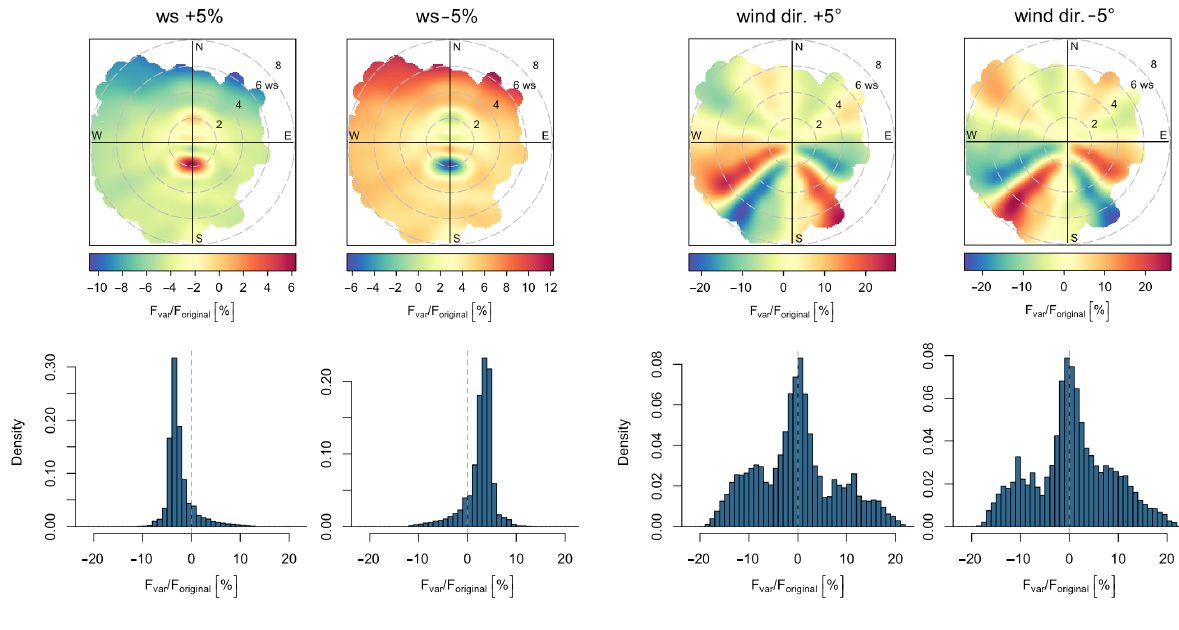
Figure 8. Variation experiment with the Operational Street Pollution Model (OSPM). For the variation of the input parameters wind speed by 5% and the wind direction by ± 5 ◦ , the output of the dilution factor F var in relation to the to the original dilution factor F original is displayed. In the upper row the quotient is shown as polar plot, in the lower panel as histogram of the